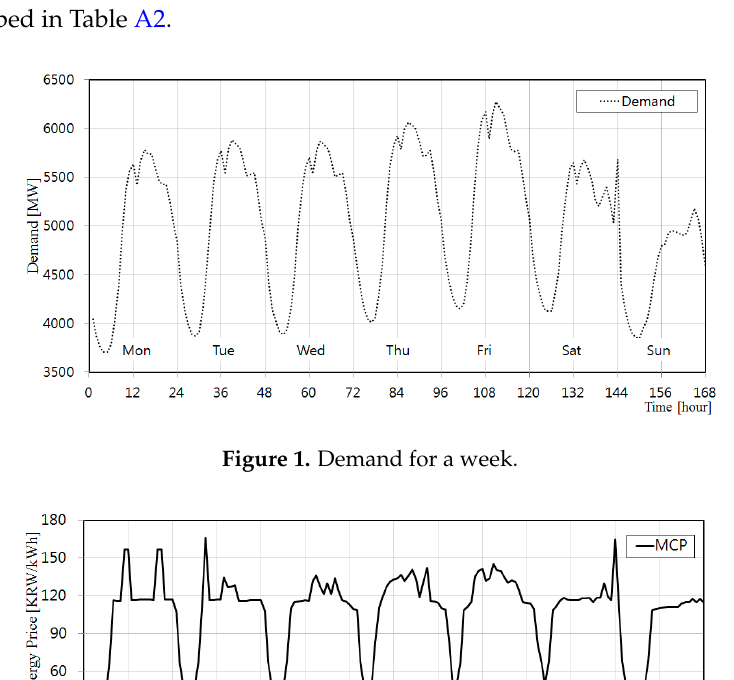
Figure 2. Hourly energy prices for a week (2 ‒ 8 August 2010).